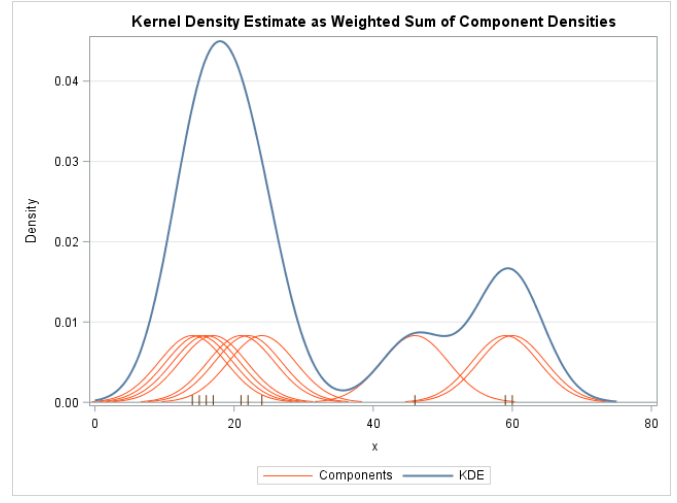
Figure 6. The Kernel Density Estimation used to create bins for the lookup table.